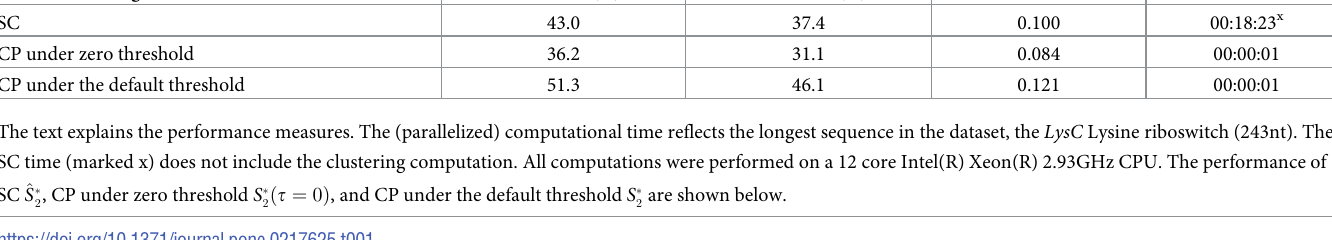
step of SC alone took more than 18 mins.